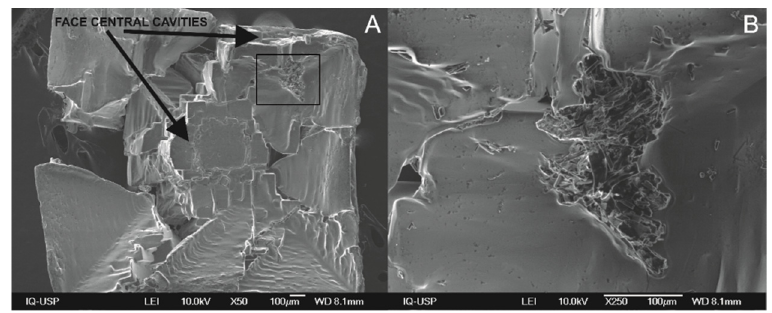
Figure 12. SEM image of ( A ) NaCl seed grown after 60 min on the NaCl–CaSO 4 –H 2 O droplet under evaporation and ( B ) CaSO 4 on the surface of the grown seed (square on A indicates the enlarged area shown on ( B )).